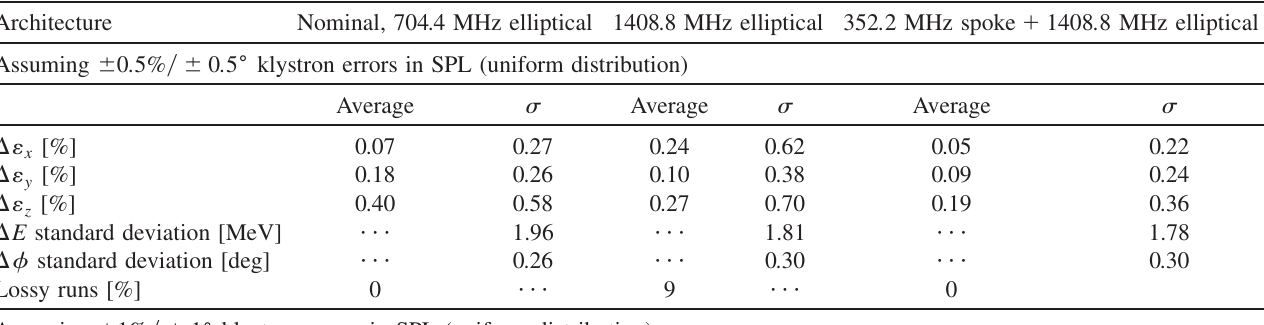
TABLE VI. Additional rms emittance growth for simulations with statistical longitudinal errors, assuming (cid:4) 1% = (cid:4) 1 (cid:5) (uniform distribution) klystron errors in Linac4. Emittance errors are quoted as average (cid:4) 2 (cid:2) standard deviation. Architecture